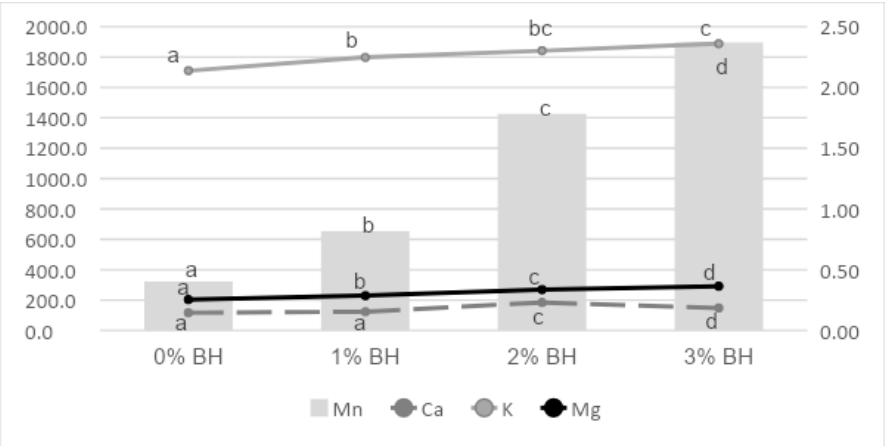
Figure 3. Effect of BH on mineral content in sausages (mg/kg). a–d—different letters indicate significant differences ( p ≤ 0.05) between values.